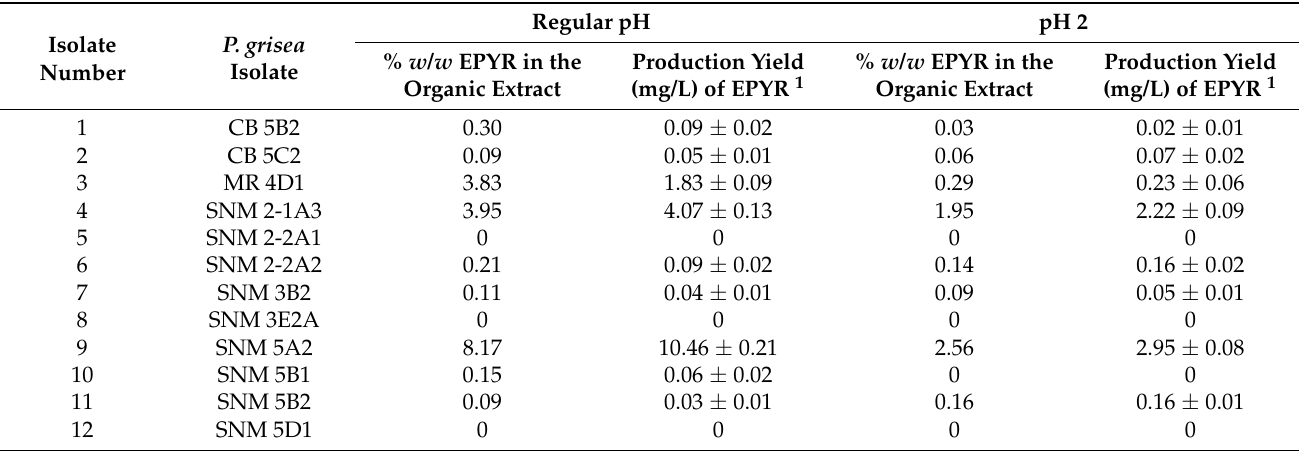
Table 3. Relative amount (% w/w ) of EPYR in the organic extracts of Pyricularia grisea isolates (1–12) obtained at regular pH and pH 2 and its production yields (mg/L) in PDB liquid culture calculated with EPYR data amounts using the developed HPLC